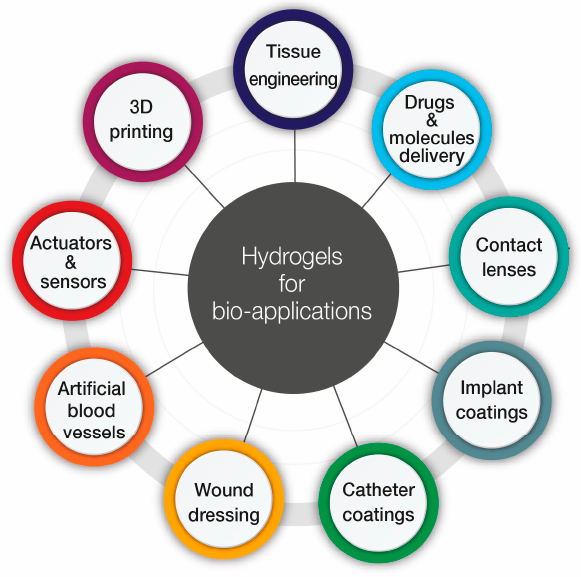
Figure 1. Application of hydrogels in biomedicine.